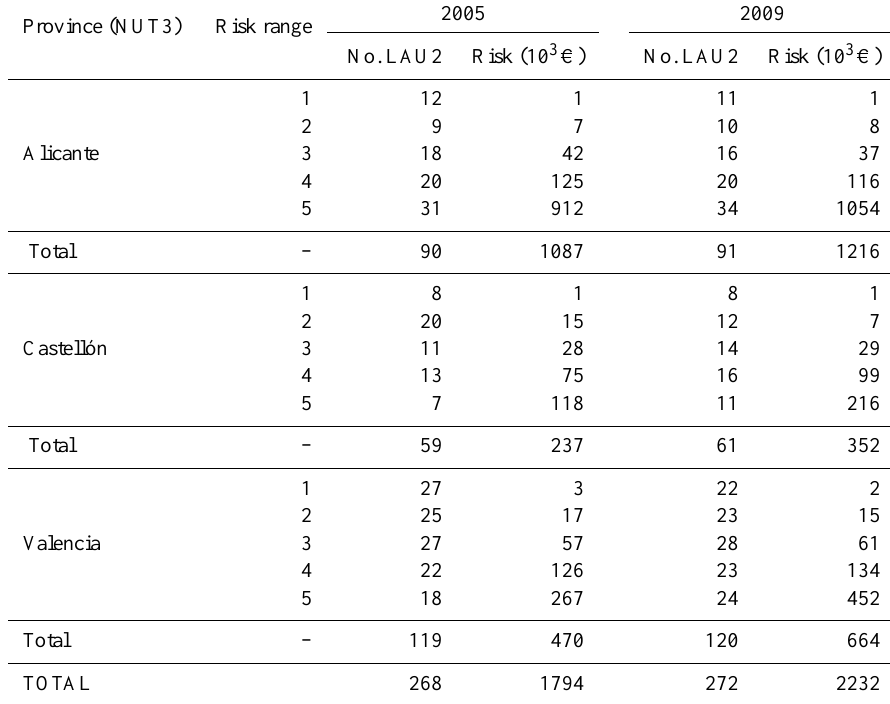
Table 12. Risk ranges by municipality (thousands of